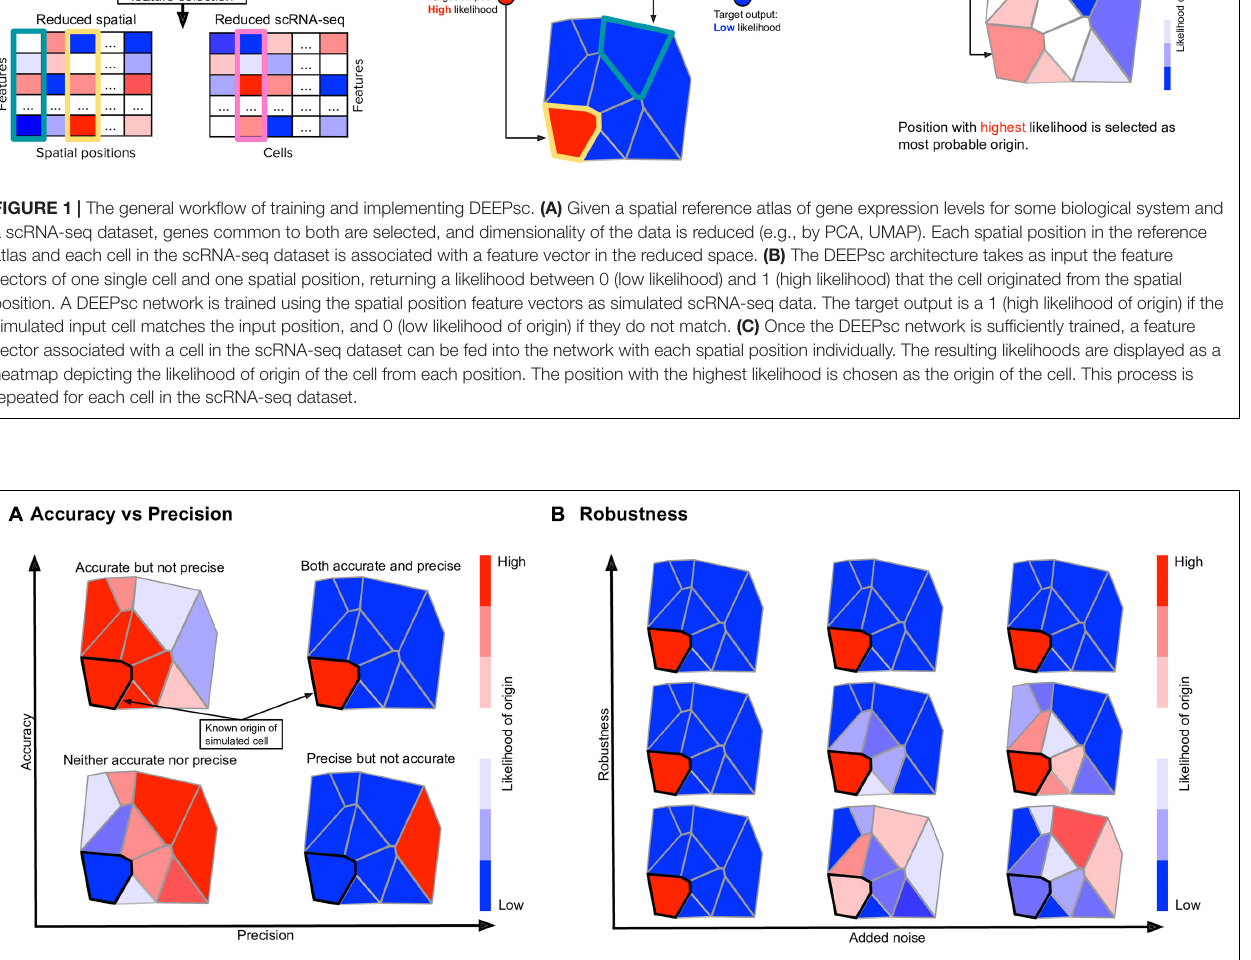
FIGURE 2 | Explanation of the terms constituting the performance score. In each hypothetical mapping heatmap, the known location of the input cell is highlighted in black. (A) The accuracy score measures whether or not the known location receives a high likelihood; the precision score measures whether or not other locations receive low likelihoods. (B) The robustness score measures how much the accuracy and precision scores change if random noise is added to the input cell. A mapping method which is accurate, precise, and robust is given a high performance score while a mapping method that lacks in any or all of the three areas is given a lower performance